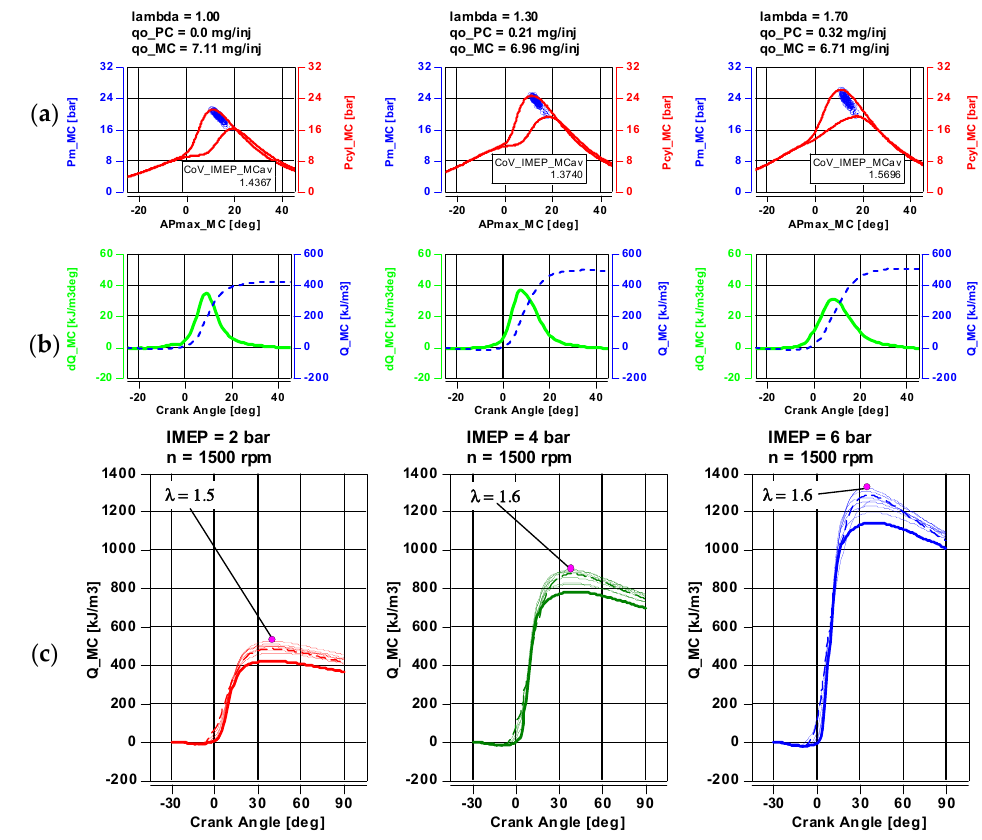
(a) at IMEP = 2 bar: SOC PC = 6 to 0 CA deg bTDC, (b) at IMEP = 4 bar: SOC PC = 6 to 2 CA deg bTDC, (c) at IMEP = 6 bar: SOC PC = 10 to 2 CA deg bTDC. While researching the combustion process, 100 consecutive cycles of engine operation were analyzed. The engine operation uniformity analysis was carried out using the CoV(IMEP) non-uniformity coefficient. Figure 10 shows selected engine operating points (at various λ -values) at the constant engine load value of IMEP = 2 bar. The blue dots indicate the maximum pressure value in subsequent cycles. It should be noted that this coefficient was determined with small load values that were characterized by high variability of engine operation. The conducted analyses indicated the existence of small changes in CoV(IMEP) values below 2%. This means that despite the large values of the difference between the extreme peak pressure Pmx values, the changes in CoV(IMEP) were small.